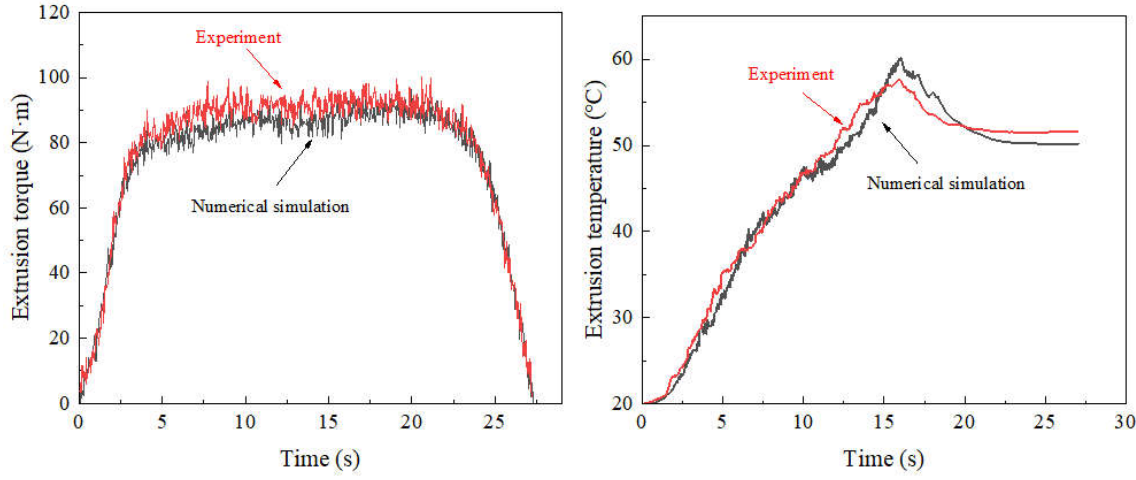
Figure 15. Error between numerical simulation and experiment. (2) Thread profile.